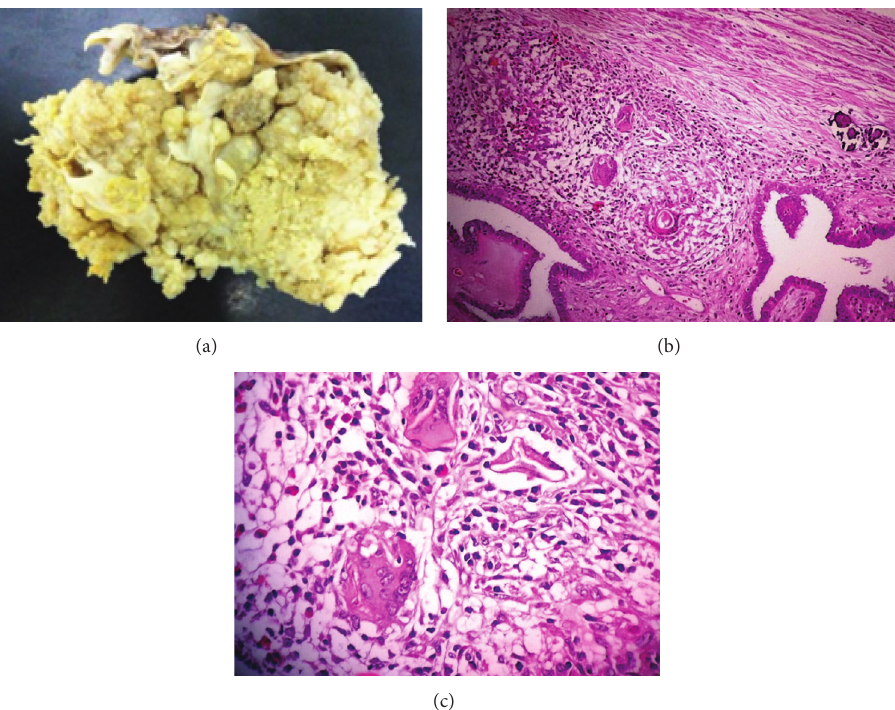
Figure 2: Case Report #2. (a) Macroscopic view of the right ovary measuring 21 × 17 × 13 cm. (b) Serous carcinoma with granulomas (hematoxylin-eosin, magnification 100x). (c) Viable S. mansoni eggs (hematoxylin-eosin, magnification